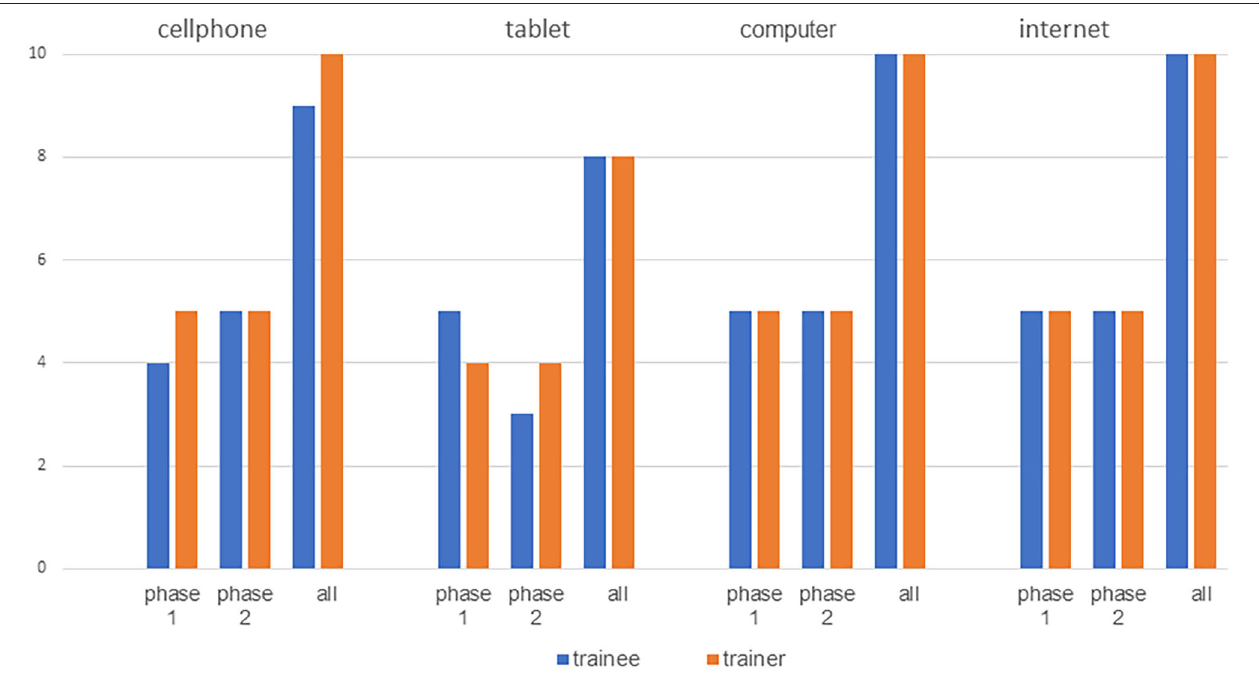
FIGURE 4 | Familiarity with technology.